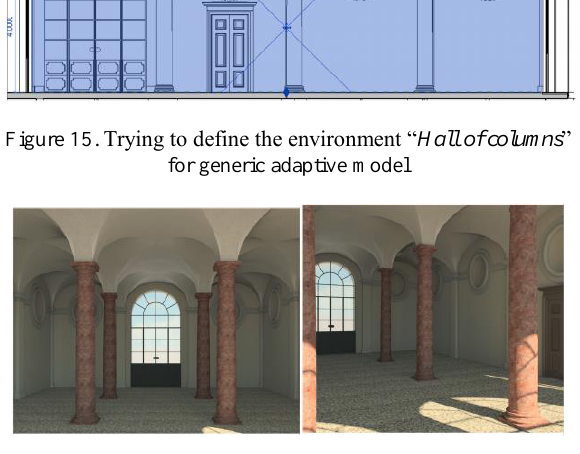
Figure 16. Rendering of the HBIM